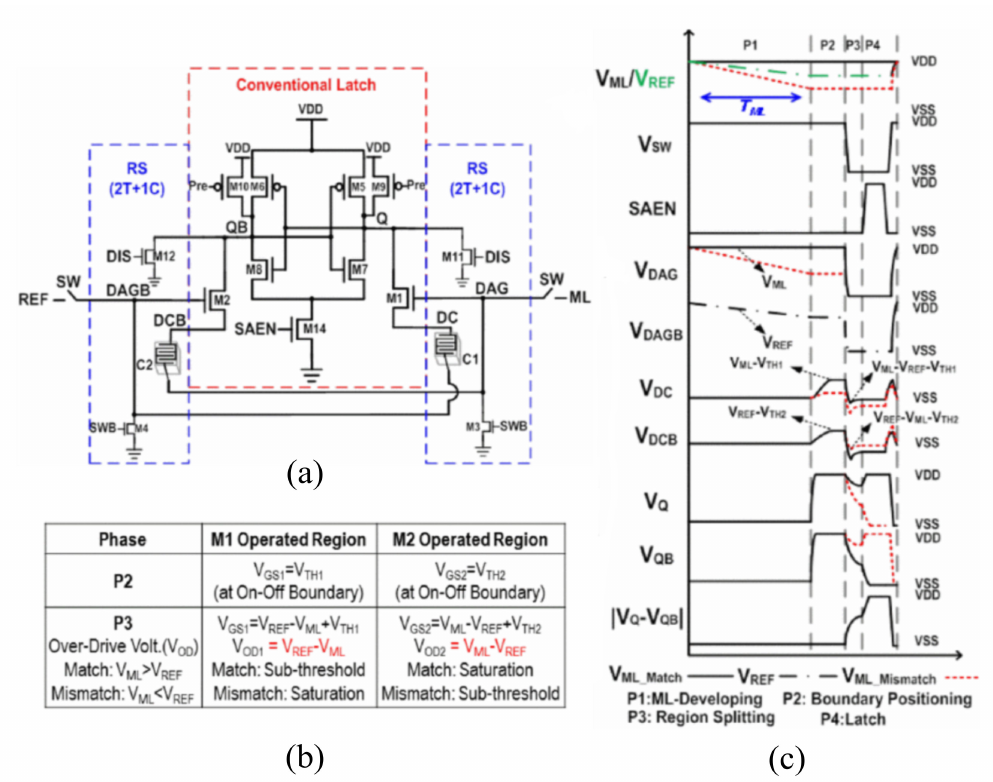
Figure 11. ( a ) The structure of RS-SA; ( b ) the state of sampling transistor; ( c ) the simulation wave- form